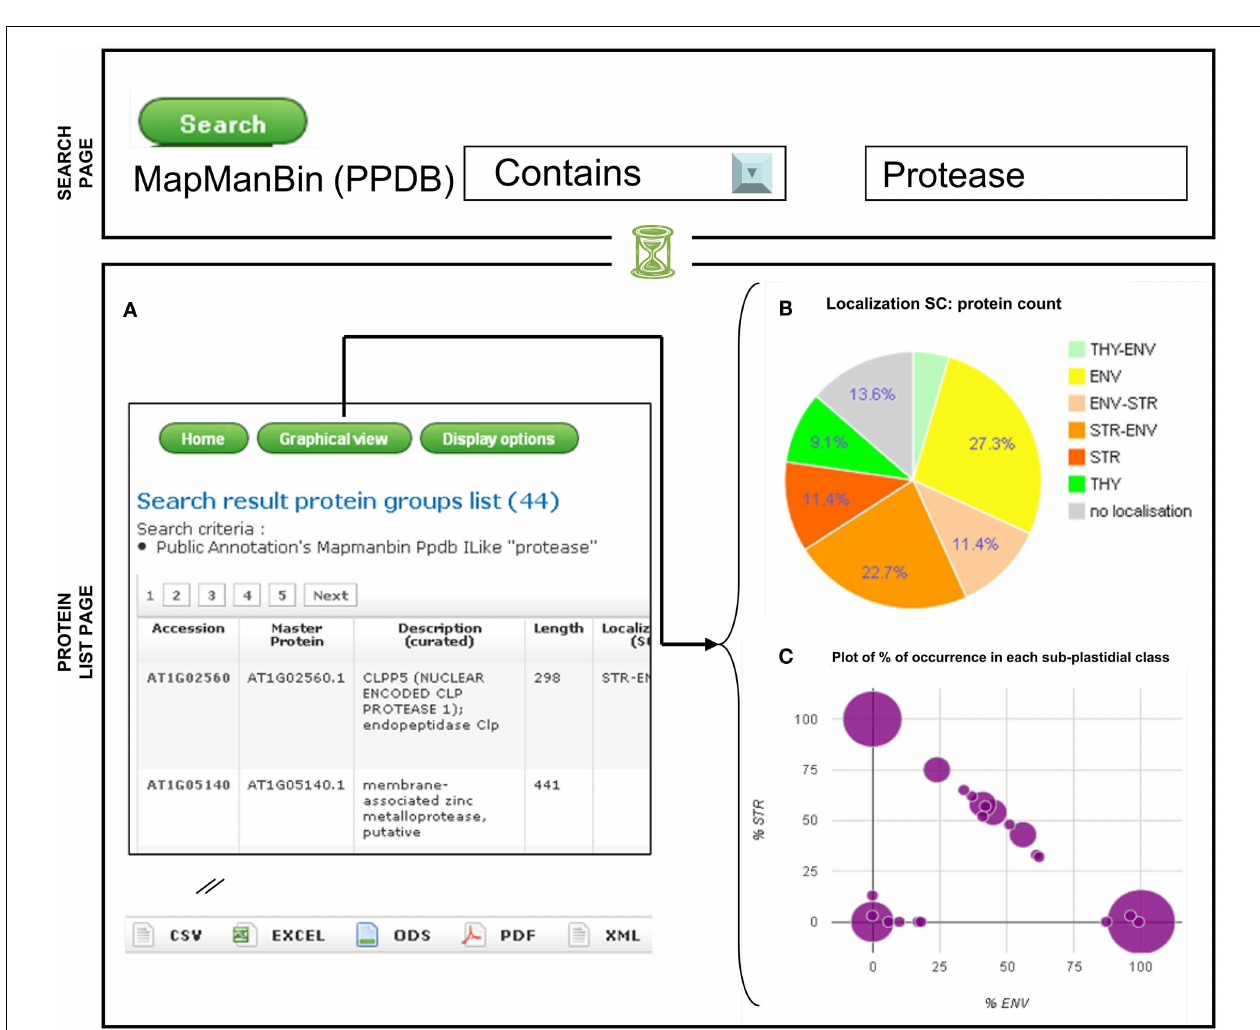
FIGURE 2 |Visualization of the sub-plastidial localization of a selected set of proteins: example of a search. Search results (A) Protein groups list; (B) Pie chart with sub-plastidial localization; (C) Plot of% of occurrence in each sub-plastidial